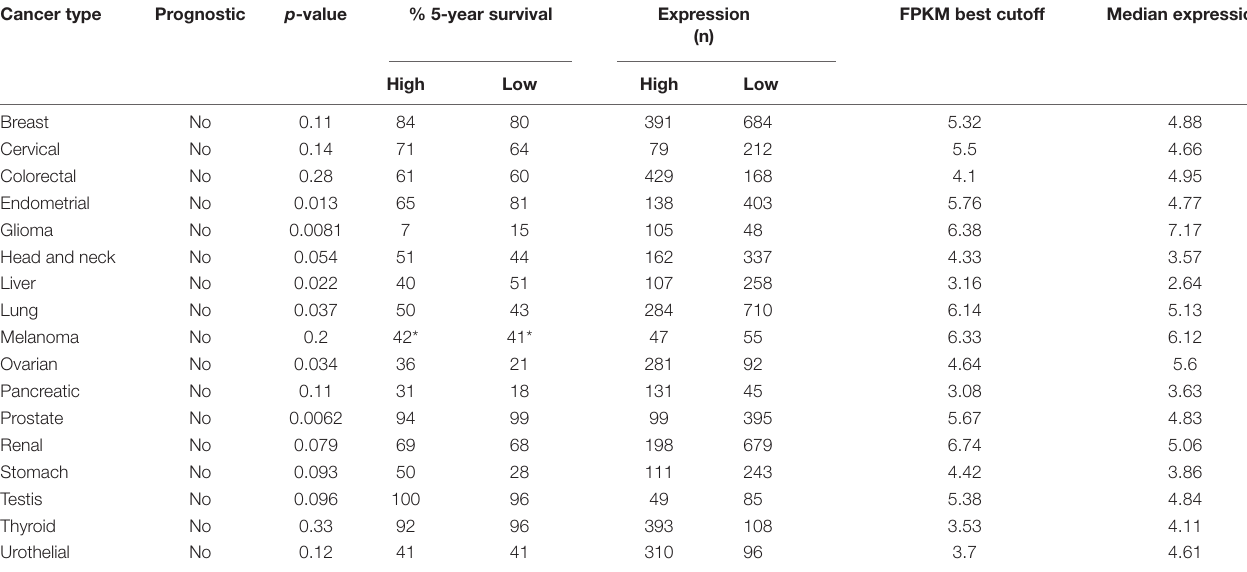
TABLE 3 | Analysis of cancer patient survival correlated with AGK expression. Cancer type